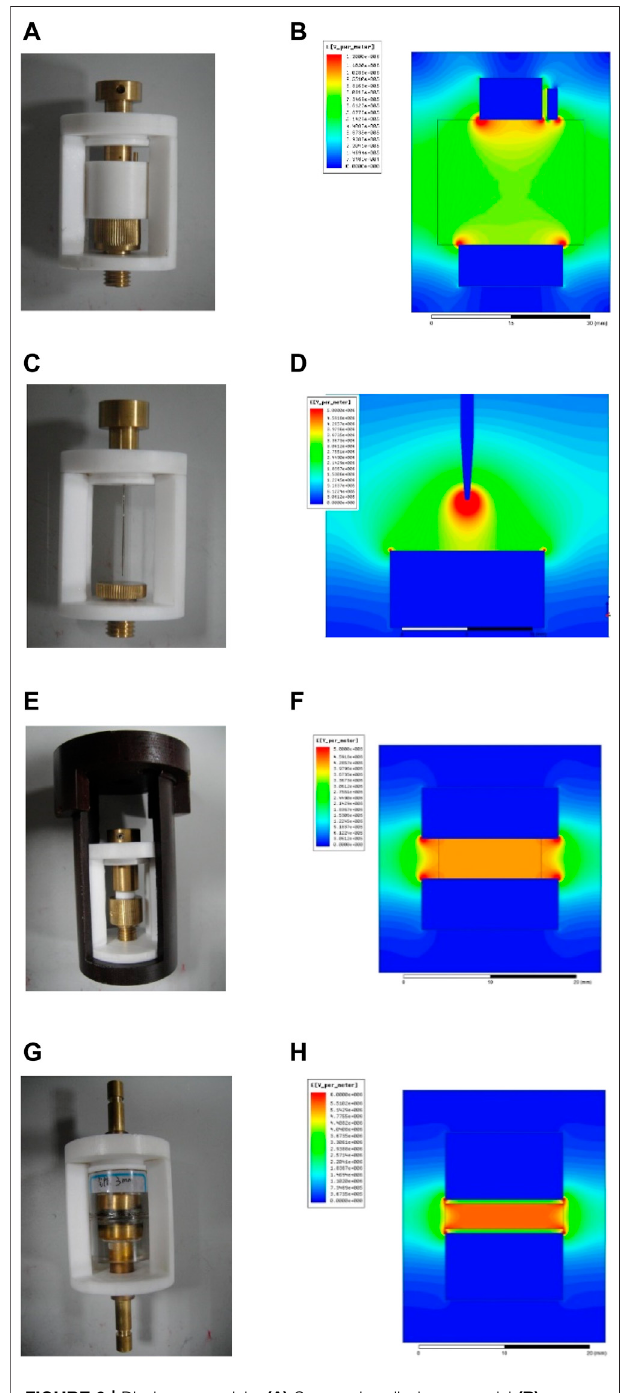
FIGURE 9 | Discharge models. (A) Suspension discharge model (B) Analysis simulation of suspension discharge model (C) Tip discharge model (D) Analysissimulationoftipdischargemodel (E) Surfacedischargemodel (F) Analysis simulation of surface discharge model (G) Oil gap discharge model (H) Analysis simulation of oil gap discharge